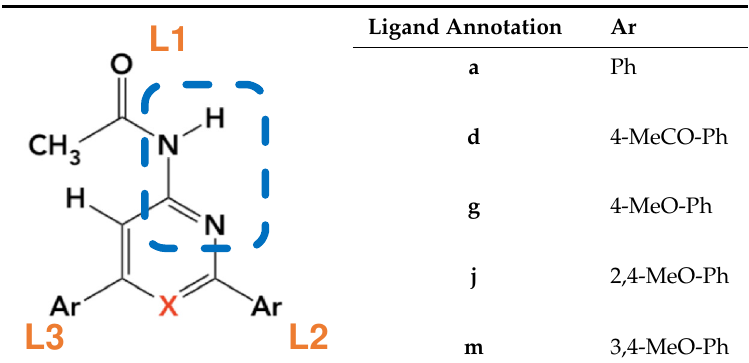
Table 1. Ligand Structures with Annotations a .